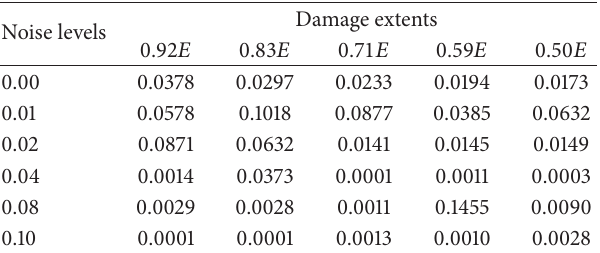
Table 12: The MAC values of multiscale damage parameter vector extracted from different load cases.